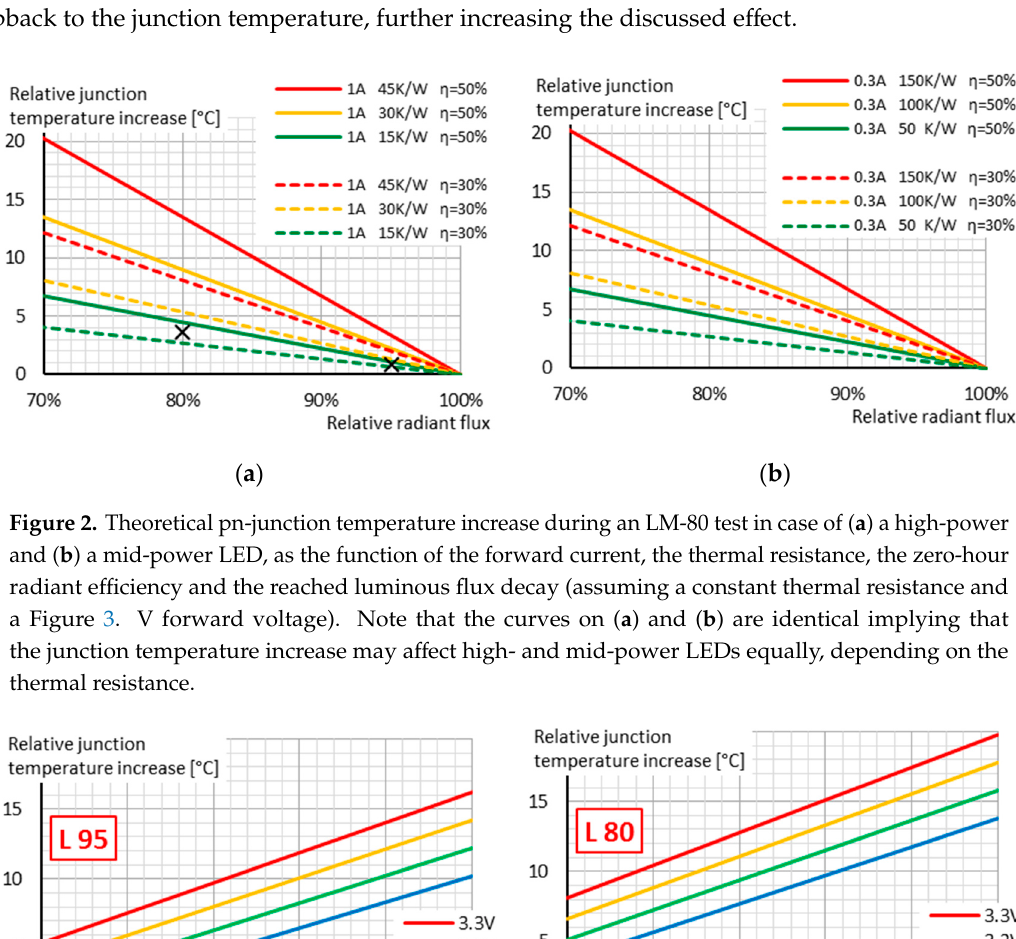
Figure 2. Theoretical pn-junction temperature increase during an LM-80 test in case of ( a ) a high- power and ( b ) a mid-power LED, as the function of the forward current, the thermal resistance, the zero-hour radiant efficiency and the reached luminous flux decay (assuming a constant thermal resistance and a Figure 3. V forward voltage). Note that the curves on ( a ) and ( b ) are identical implying that the junction temperature increase may affect high- and mid-power LEDs equally, depending on the thermal resistance.